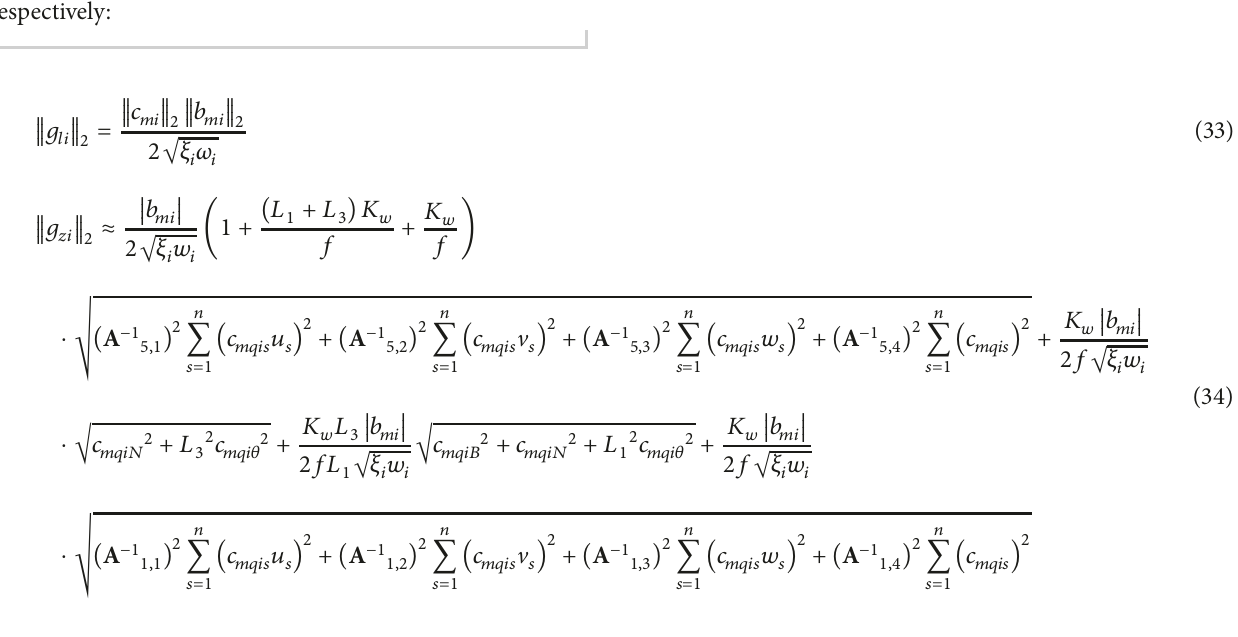
(API). An example of field testing is shown in Figure 7. Numeral 1 represents the API laser tester. Numeral 2 repre- sents the target location. Numeral 3 represents 100Kg